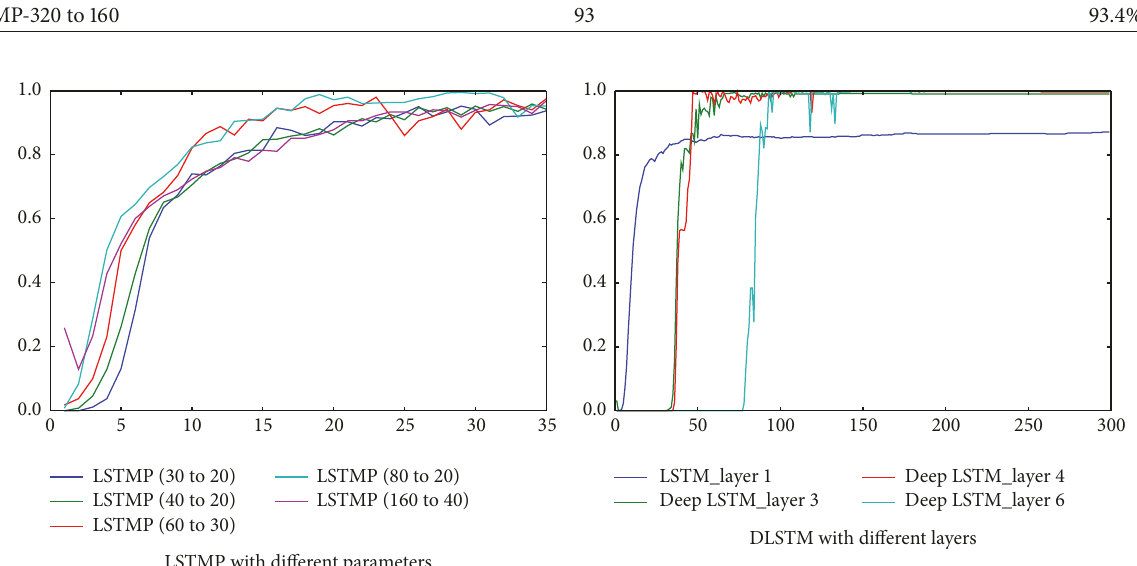
Figure 3: The recognition rates of LSTMP with different parameters and DLSTM with different